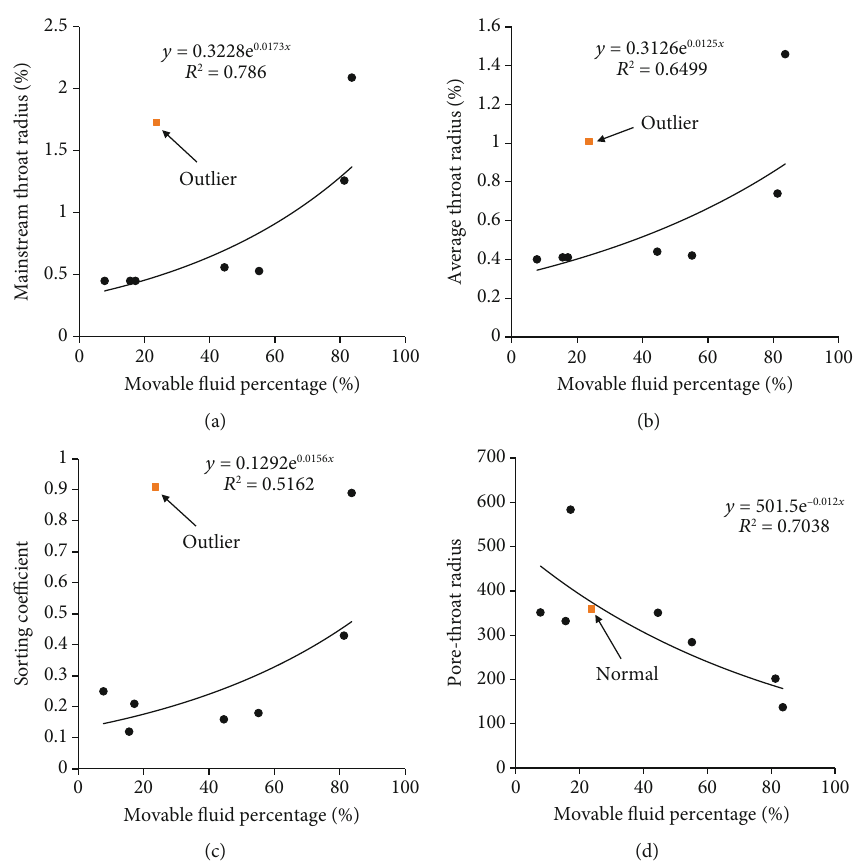
y = 0.3228e 0.0173 x R 2 = 0.786